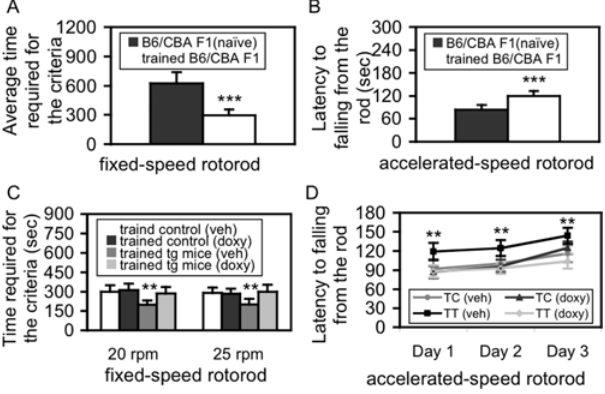
Figure 7. Interaction between NR2B expression and VMT in motor learning. A. VMT significantly enhances motor learning in fixed-speed rotorod in B6/CBA F1 mice. The average time required to reach the learned criterion from both 20 rpm and 25 rpm tests was significantly decreased (p , 0.001, Students t test) in trained B6/CBA F1 mice (n=9), compared to naı¨ve B6/CBA F1 mice (n=12). B. VMT significantly enhances motor learning in accelerated-speed rotorod in B6/CBA F1 mice. The average latency to falling down from the rod from